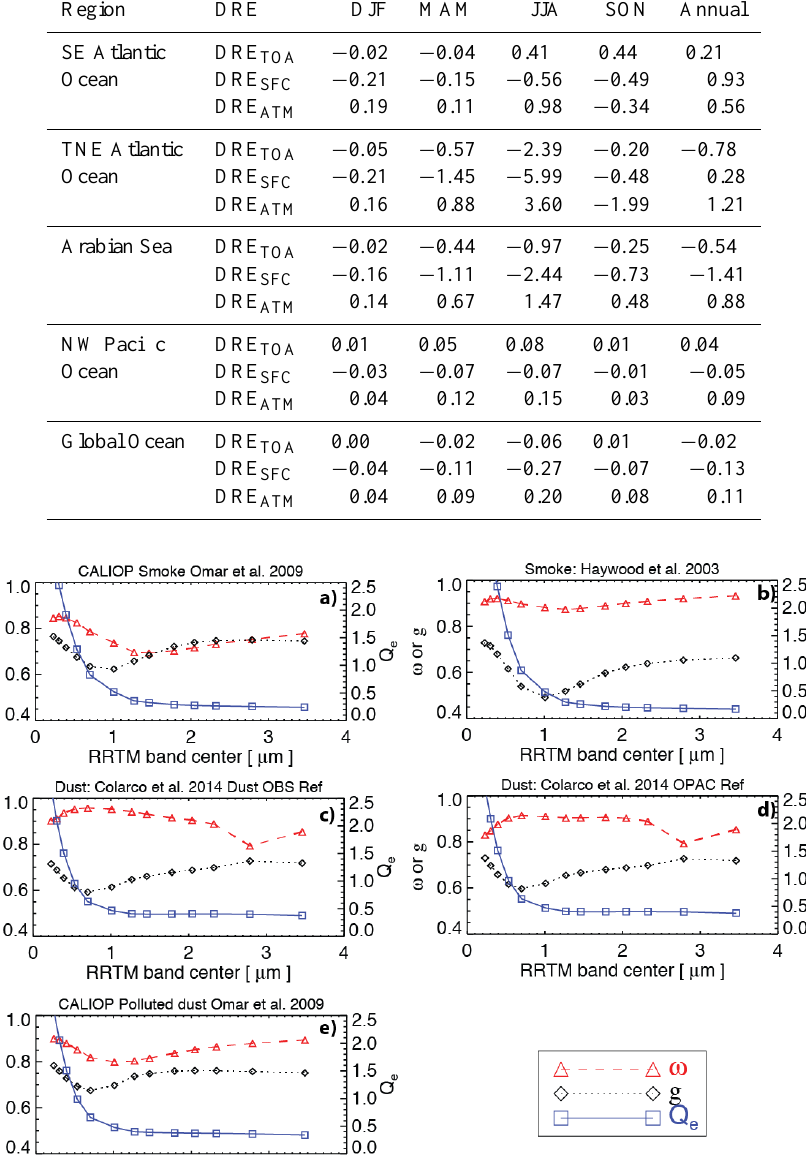
Table 2. The seasonal and annual mean of diurnally averaged cloudy-sky DREs due to ACA at TOA (numbers on the top in each cell), surface (numbers in the middle) and within atmosphere (numbers on bottom). The unit isWm − 2 .